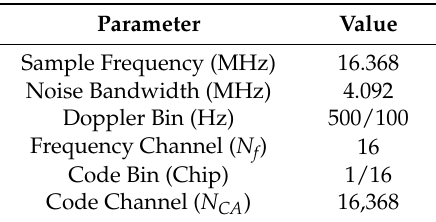
Table 2. Signal and correlation parameters.